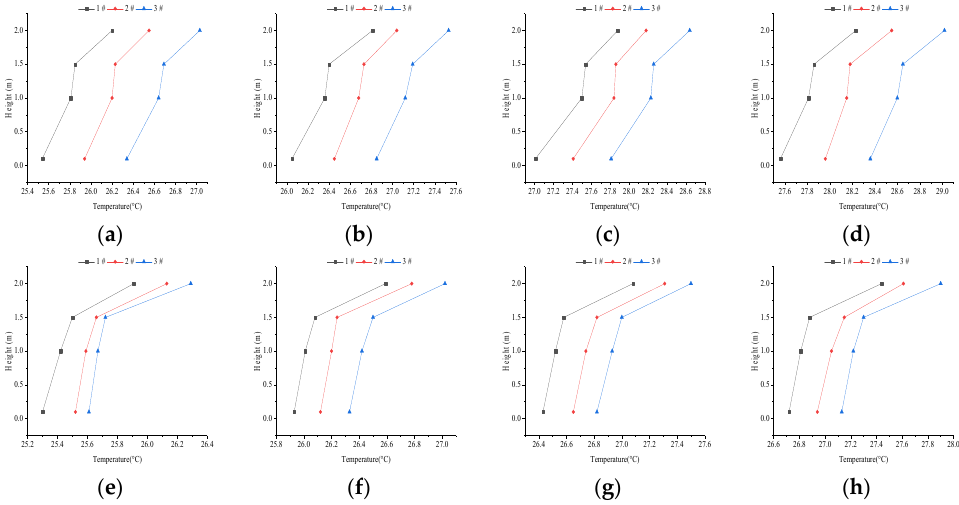
Figure 6. The indoor air temperature distributions under different supply water temperature with CTRC (( a – d ) for 12 °C, 14 °C, 16 °C and 18 °C, respectively) and CRC (( e – h ) for 12 °C, 14 °C, 16 °C and 18 °C, respectively).